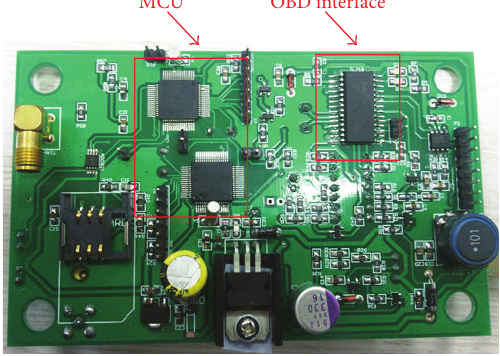
Figure 3: The top view of the terminal.